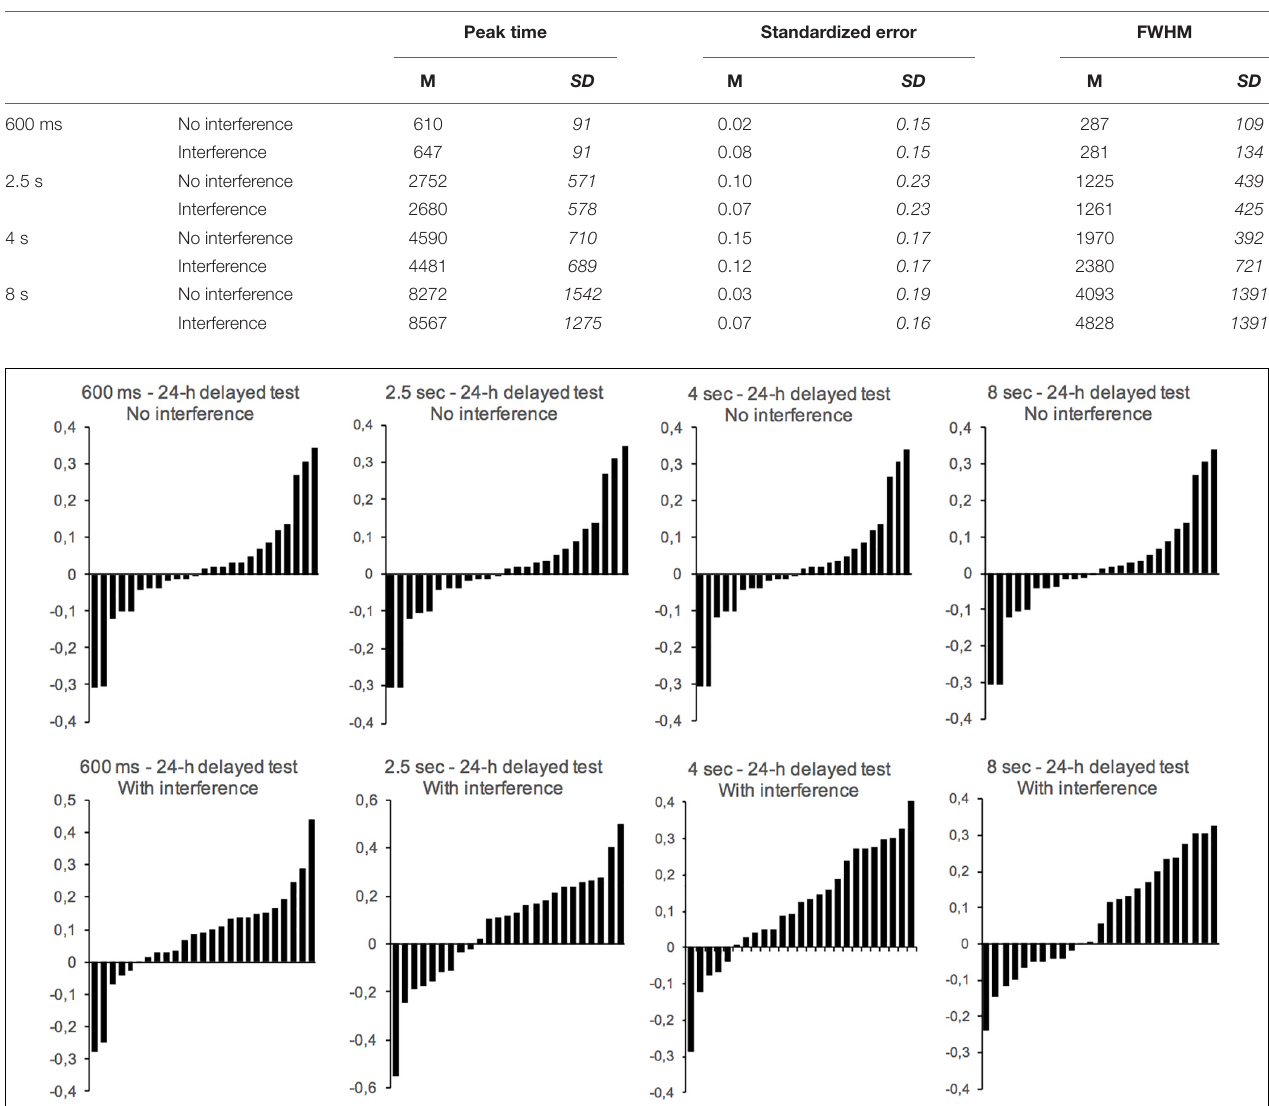
TABLE 1 | Mean ( SD ) Peak Time, Standardized Error and FWHM (variability) for the 24-h delayed test with and without an interfering task during the long-term memory consolidation process. Peak time